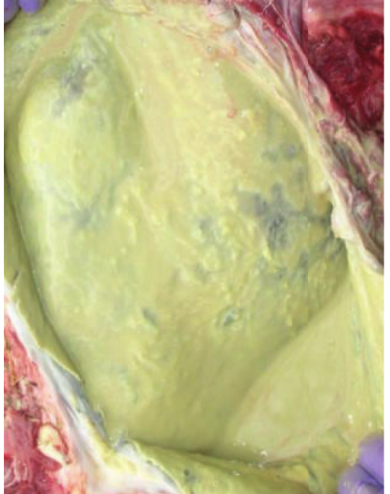
Figure 15: Thick pericardium along with septic e ff usion.